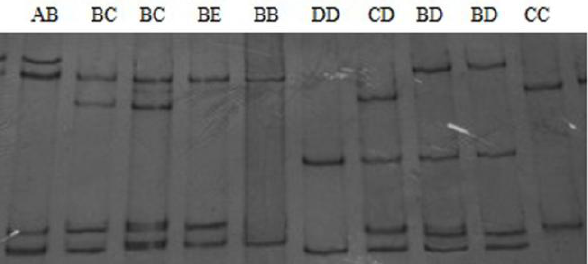
Figure 1. The genotyping results of the SLA-DQA gene exon 2 by